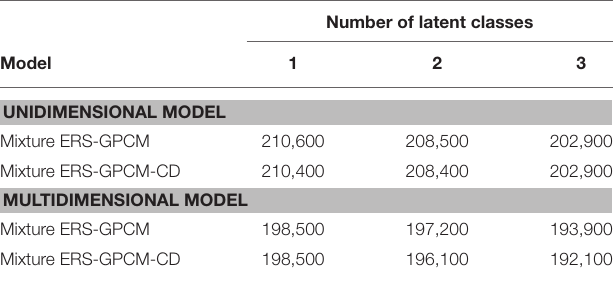
TABLE 6 | BIC values for the 12 competing